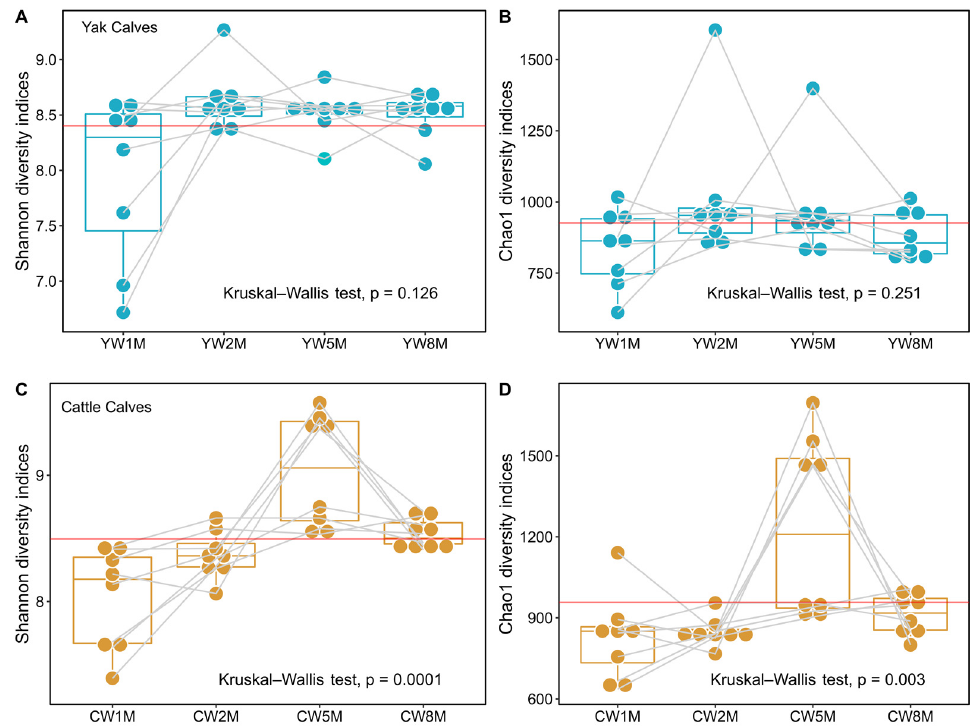
Figure 2. Alpha diversity of fecal microbiota of yak and cattle calves after weaning. The Shannon and Chao1 species richness indices in yak ( A , B ) and cattle ( C , D ) calves are shown by box plots. The Chao1 species richness and Shannon diversity indices of fecal microbes at different months after weaning were statistically analyzed by the Kruskal–Wallis test. The red line represents the intergroup average. The light gray line represents the diversity of fecal microbiota in the same individual in different months after weaning.